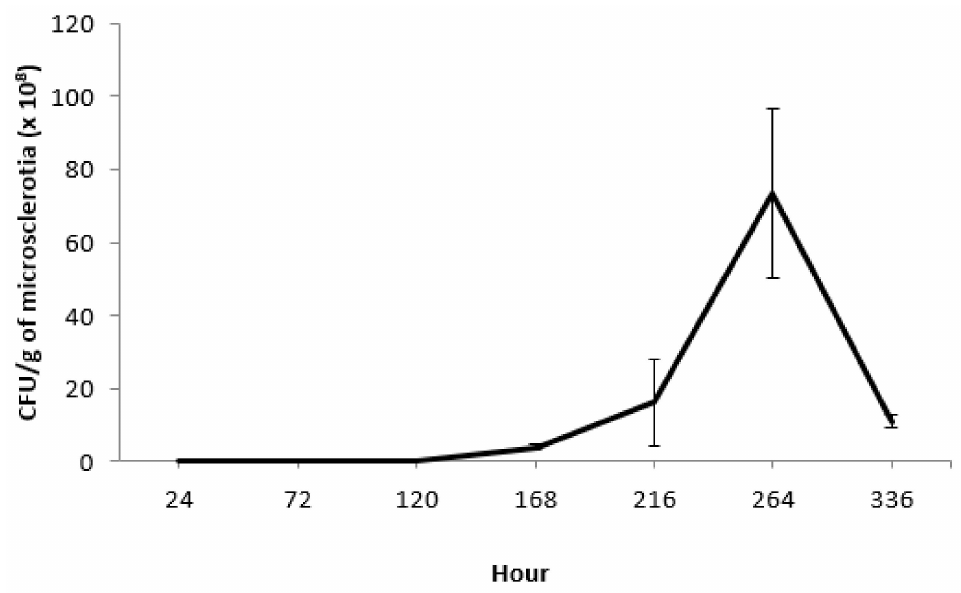
Figure 4. Time course of CFU yield (mean ± SE) of M. brunneum strain EAMa 01/58-Su microsclerotia as a function of incubation